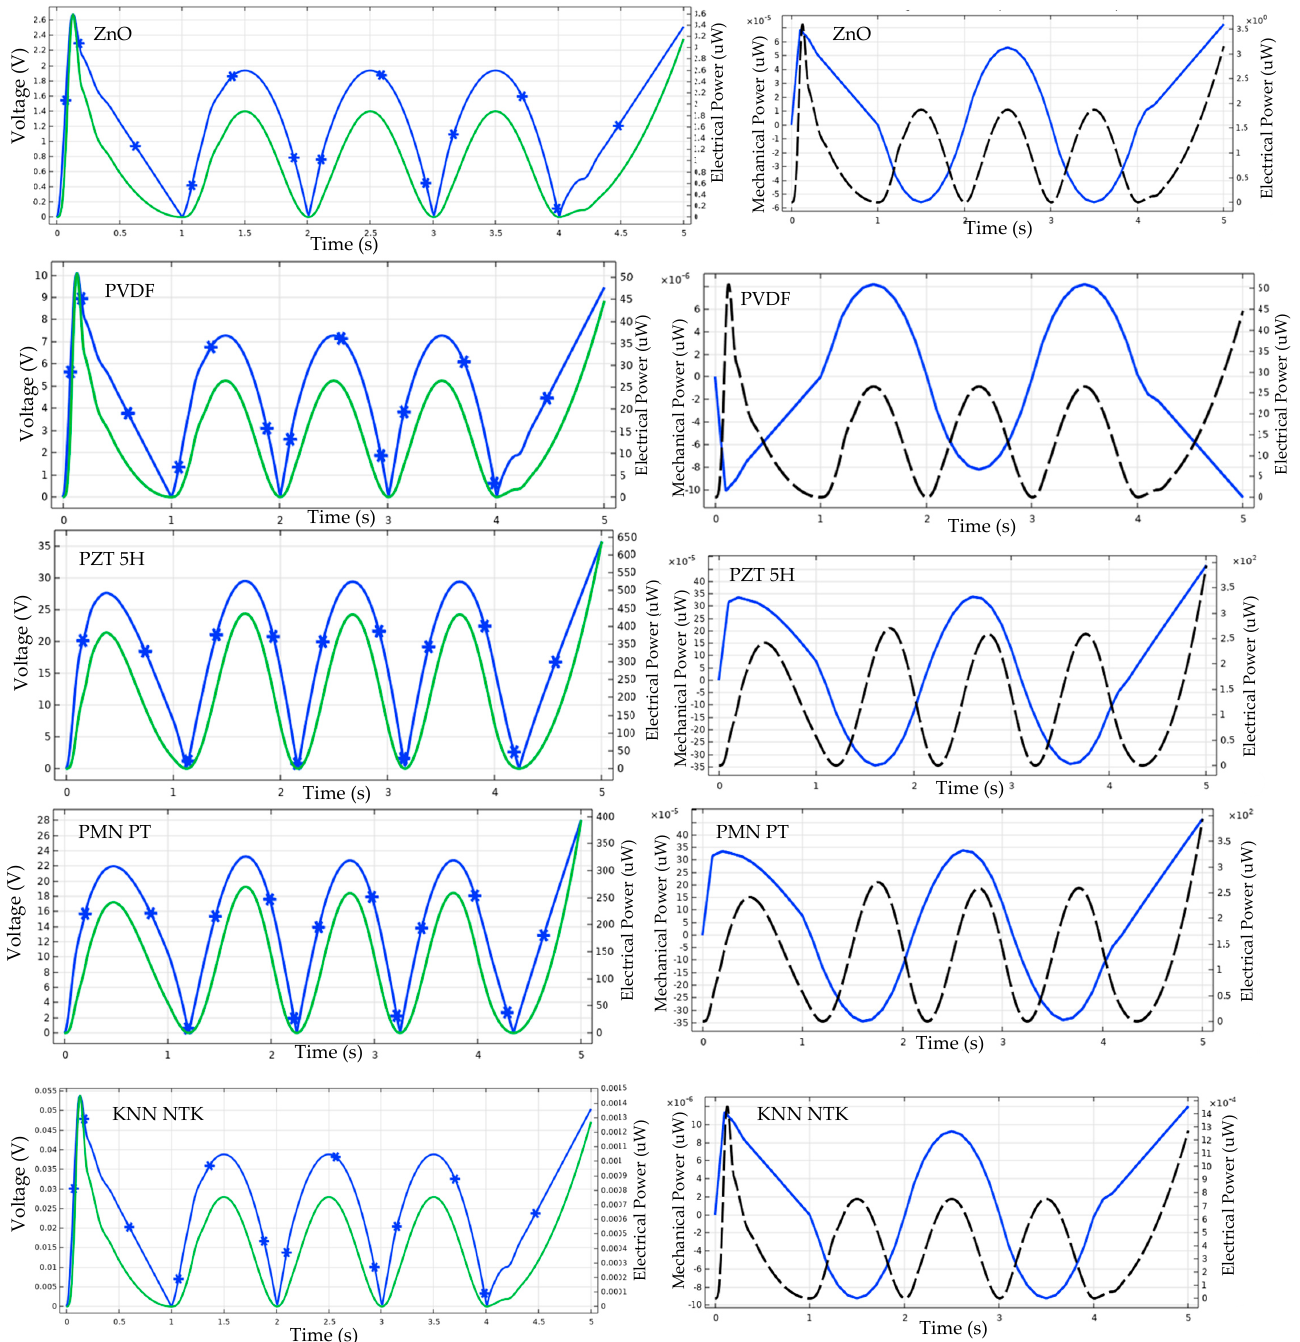
Figure 6. The axial-loading response of thin-film energy harvesters ( left ) and the mechanical power input vs. the electrical power output ( right ).